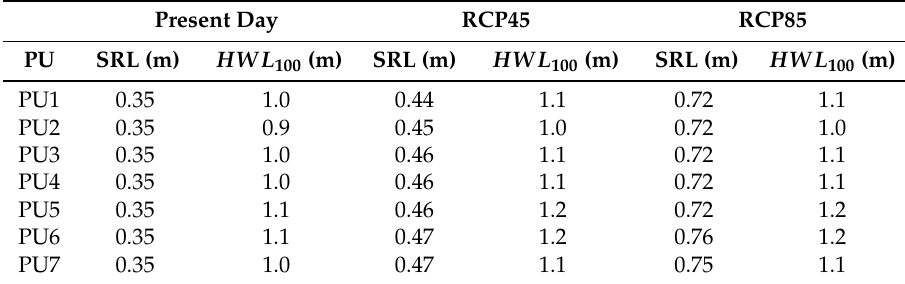
Table 3. Median present-day 100-year HWL ( HWL 100 ) and projected sea level rise; SRL and HWL 100 under RCP4.5 and RCP4.5 by 2110. Values extracted from the LISCoast database have been averaged in each Physiographic Unit